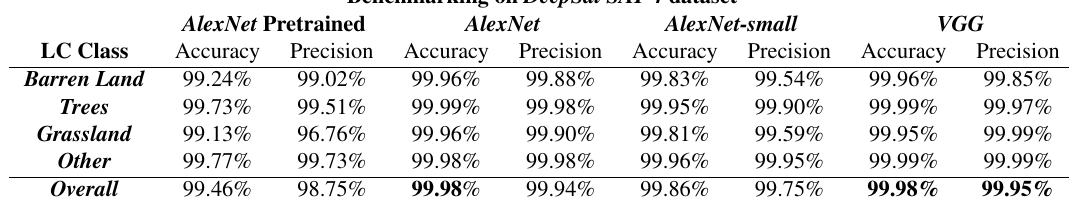
Table 1: Resulting classification accuracy and precision rates after the application of different deep architectures in the SAT-4